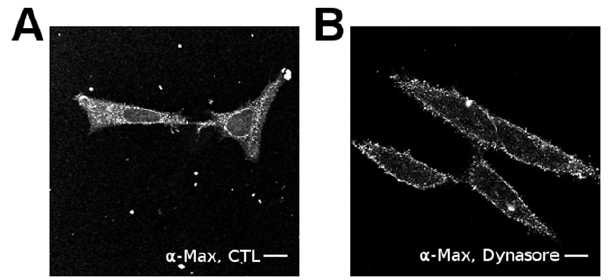
Figure 5. The transduction of Max* in HeLa is blocked by Dynasore. Confocal immunofluorescence photomicrographs of HeLa cells incubated with Max* for 20 minutes at 37 u C (subsequent to a 30 minutes pre-incubation period at 4 u C) in the absence A) or presence of B) 25 m M Dynasore. Scale bar=10 m m.